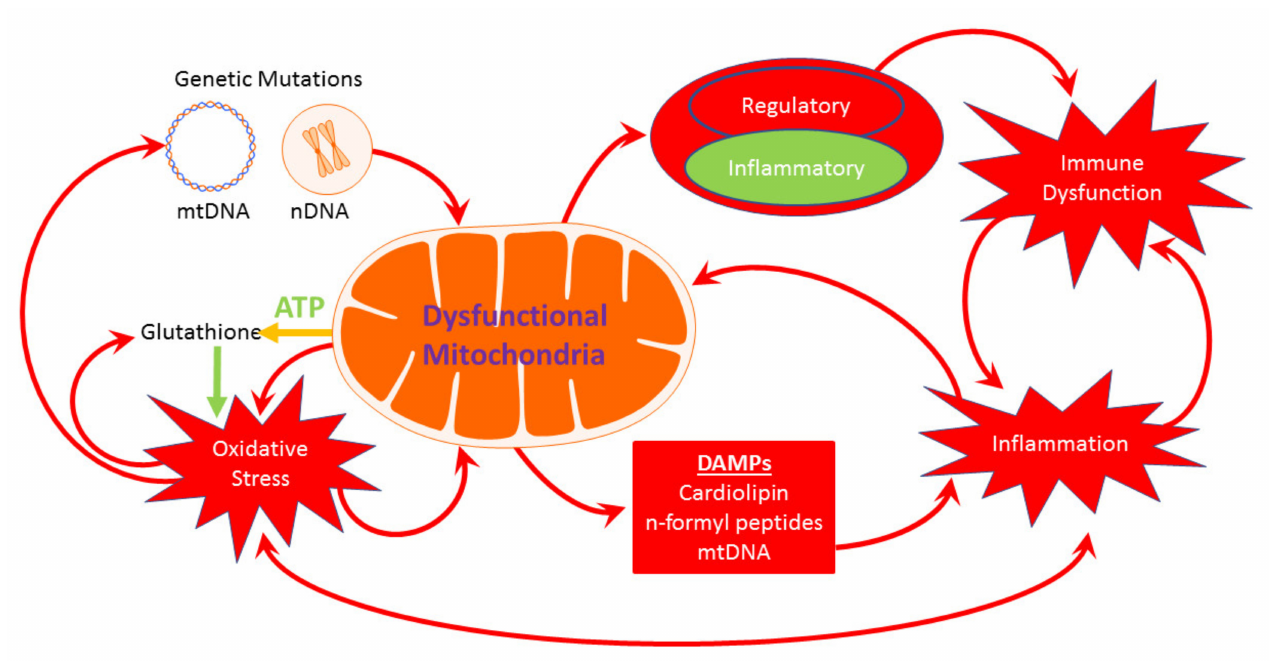
Figure 2. Self-perpetuating destructive cycles which can result in mitochondrial